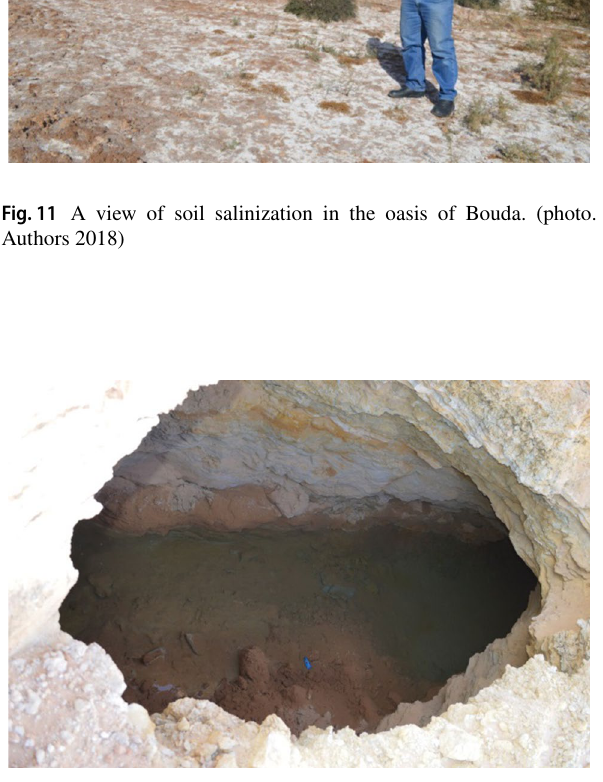
Fig. 12 Landslide in the gallery of the foggara of Mohamed Abdel- lah. (photo. Authors 2018)